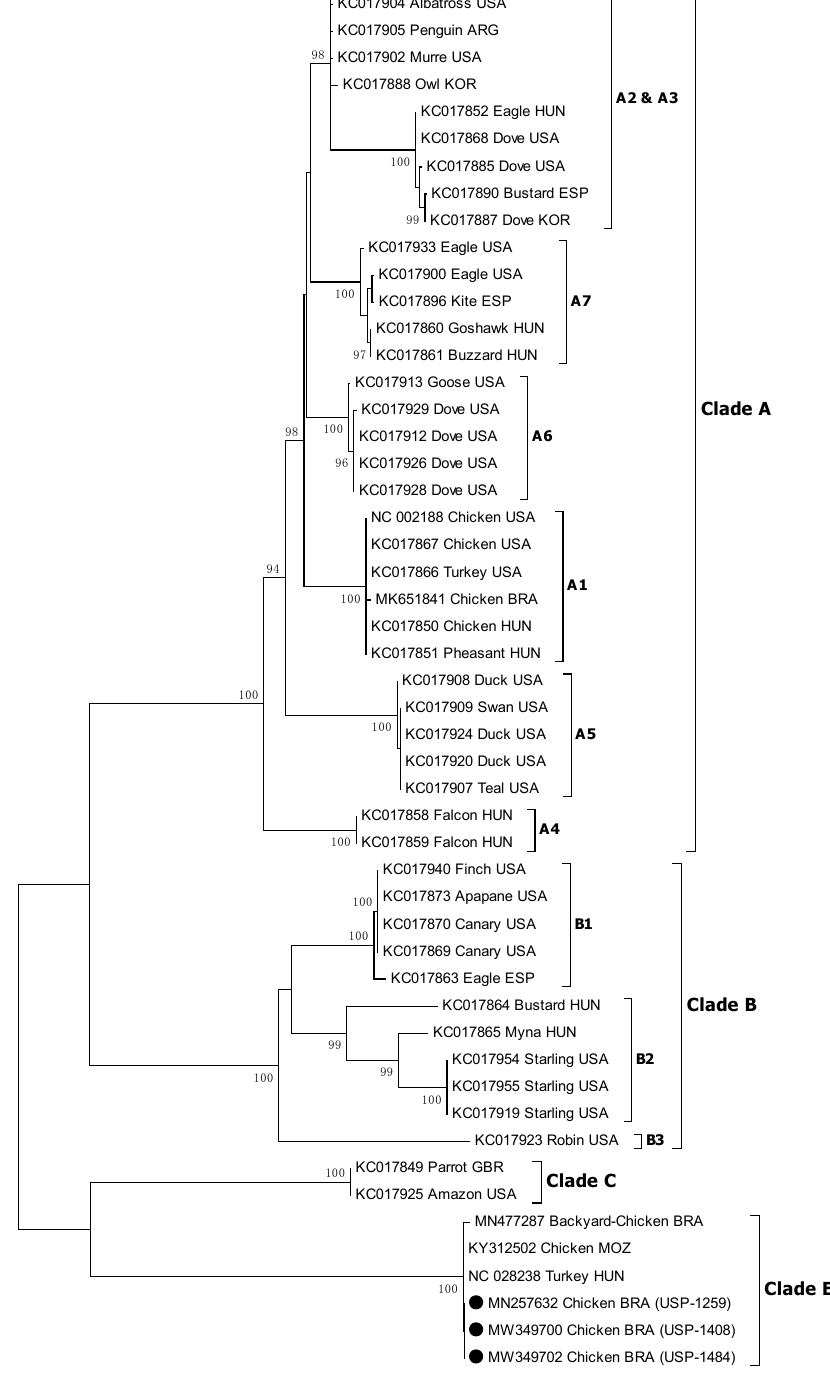
Figure 10. Phylogenetic analysis of partial DNA polymerase ( pol ) gene of APV strains. Strain names and GenBank accession numbers are shown. The black circles represent field APV strains of this study. Phylogenetic trees were constructed in MEGA v7.0 using the neighbor-joining method with 1000 bootstrap replicates. The evolutionary distances were computed using the Tamura-Nei model (TN93 + G + I). Node values represent percentage support and scale bar represents the number of base substitutions per site. Brazilian strains of this study are represented by filled circles.